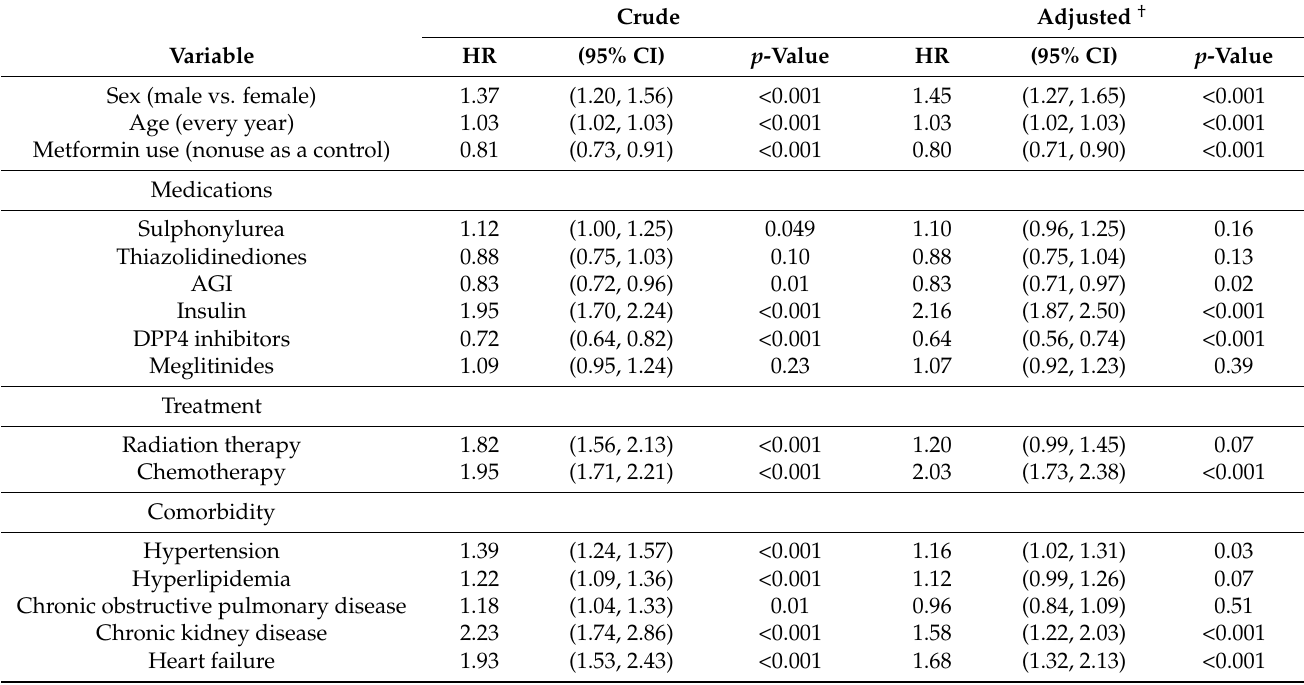
Table 3. Hazard ratio and 95% confidence interval of death due to nasopharyngeal cancer associated with medications, treatment, and